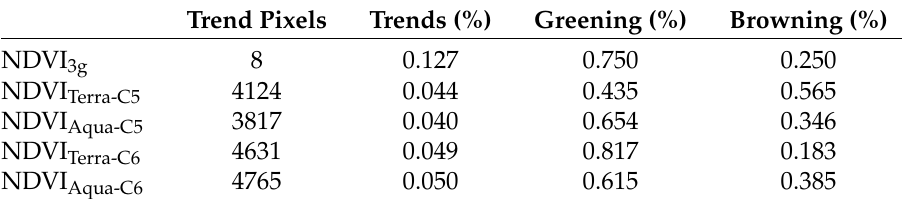
Table 2. Product-specific pixel amounts of “significant” monotonic trends ( p < 0.05; Figure 2).